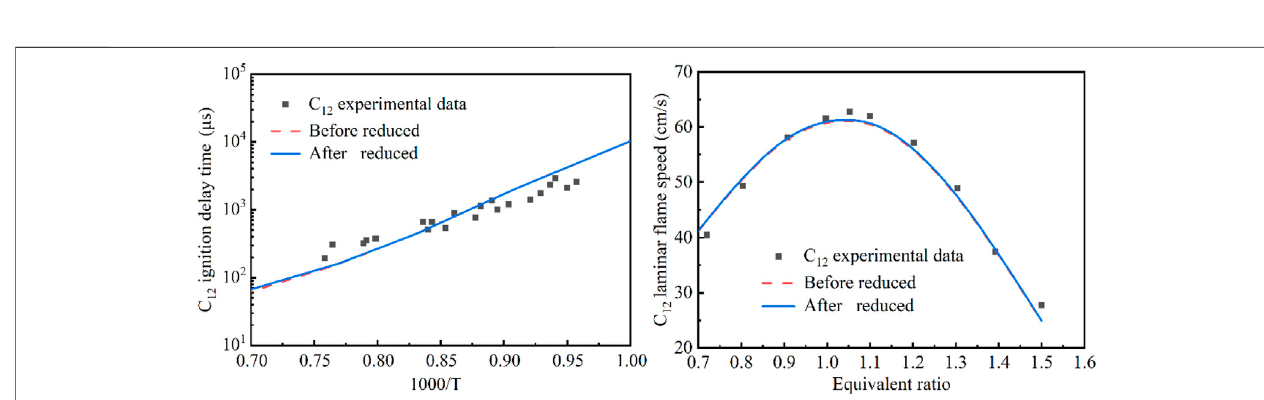
FIGURE 3 | Comparison of the original and simpli fi ed models for the methane reaction system (Lifshitz et al., 1971; Zhu et al., 1989) (Red - original model; Blue - reduced model. Left plot: ignition delay time at p (cid:2) 9 atm, 0.0212CH 4 + 0.0212O 2 + 0.9576AR; Right plot: laminar fl ame speed at T (cid:2) 300 K, p (cid:2) 1 atm).